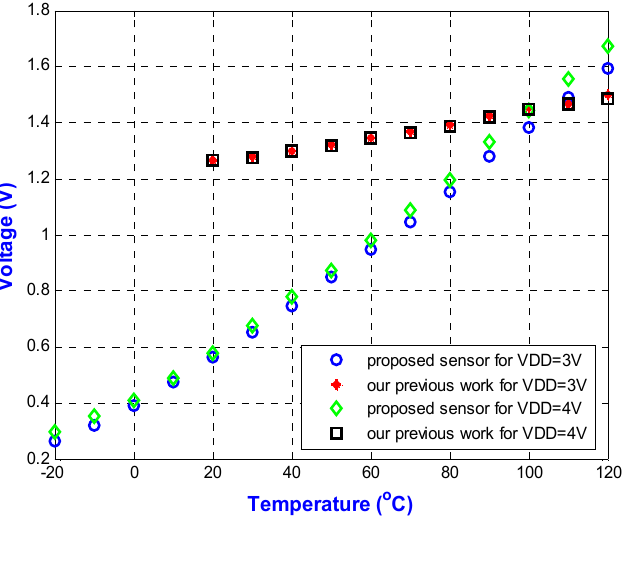
Figure 16. Comparison of the measured output voltage for the proposed temperature sensor and our previous work